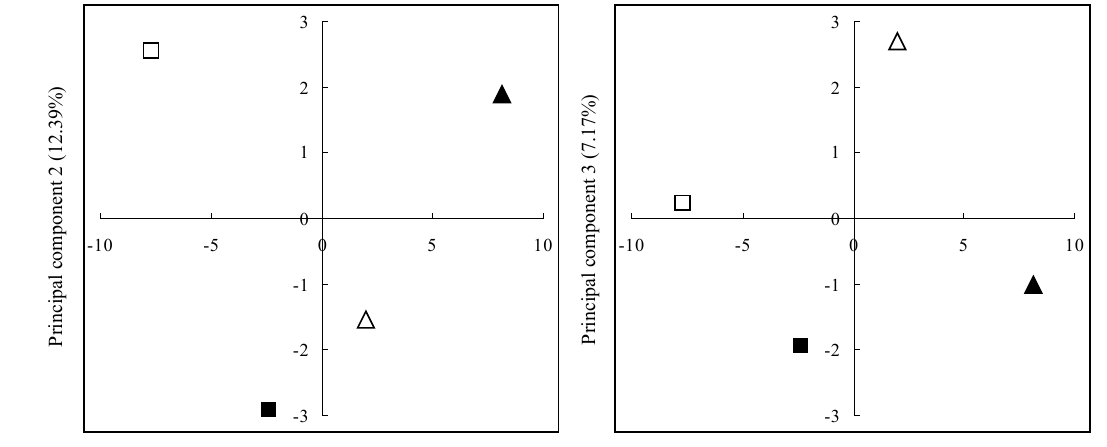
Fig. 2: Principal component analysis of aroma substances in tea leaves. ▲ : 0 a,  : 4 a, ■ : 9 a,  : 30 a.